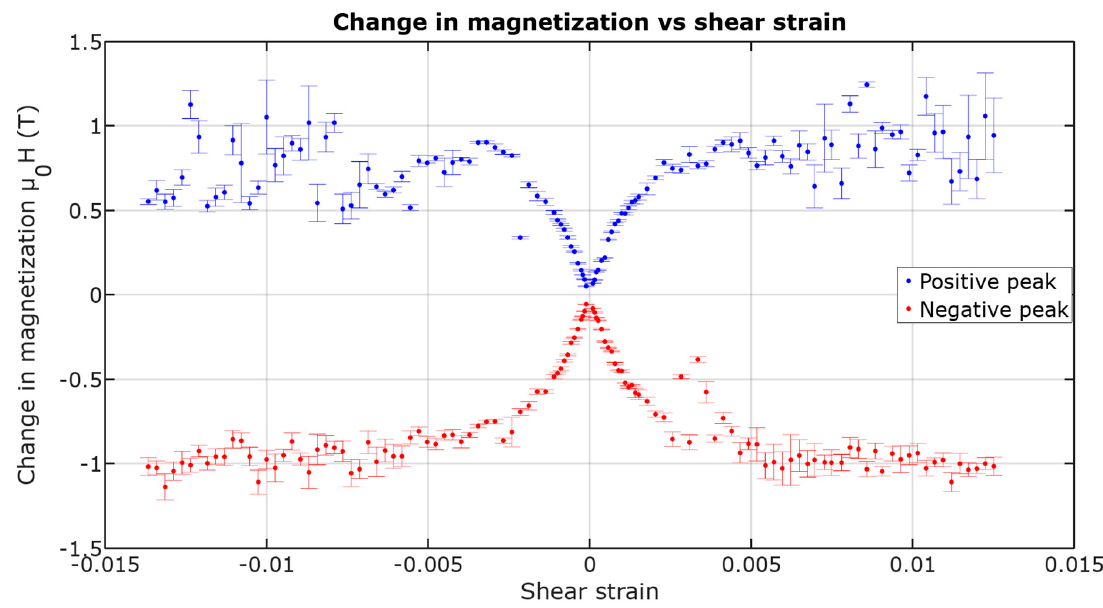
Figure 7. Magnetization change in function of shear strain ( ± 1 std. deviation).